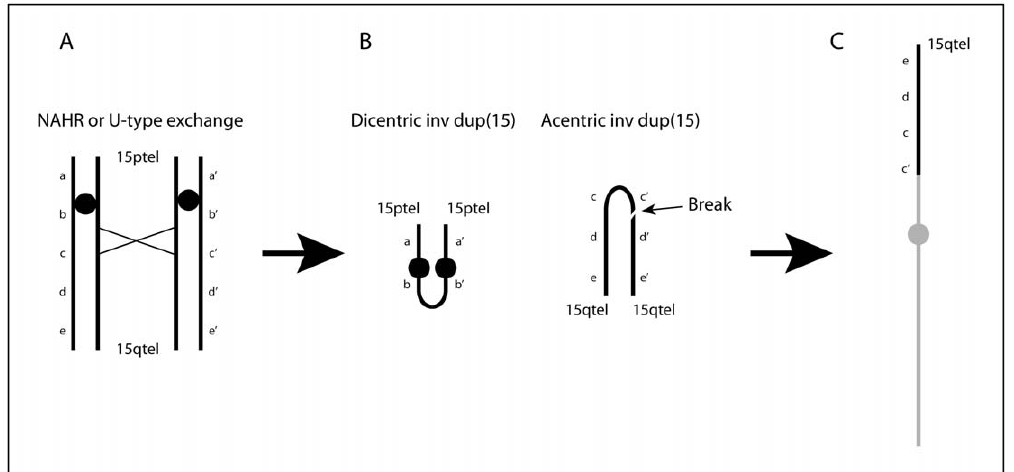
Figure 3. Schematic drawing of the putative mechanism leading to de novo unbalanced 15q translocations. (A) at meiosis, NAHR or U- type exchange, among others between LCRs BP3: BP3 or BP4: BP5, create (B) a mirror dicentric chromosome containing the p-arm and proximal q arm and a mirror acentric chromosome containing two copies of most of the q-arm. Rearrangements mediated by BP4: BP5 will generate dicentric and acentric chromosomes containing one copy of the sequence between the repeats including the PWS/AS region (not shown). The acentric/neocentric chromosomebreaks,probably randomly, intwo fragments of differentsize and(C) one of themattaches to thedistal portion of a receivingchromosome (grey line). Attachment of the larger fragment containing an inverted duplicated portion, as in our Case 1, is depicted in the drawing.